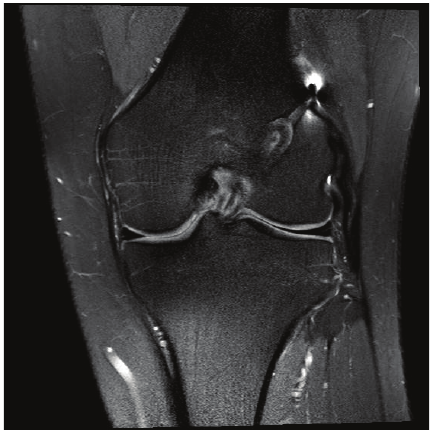
Figure 3: Postoperative coronal MRI scan of the left knee at 16 months demonstrating an intact, well-tensioned reconstruction with no signs of complications.